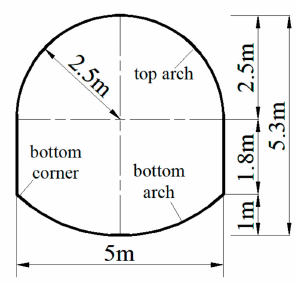
Figure 4. Set model size.